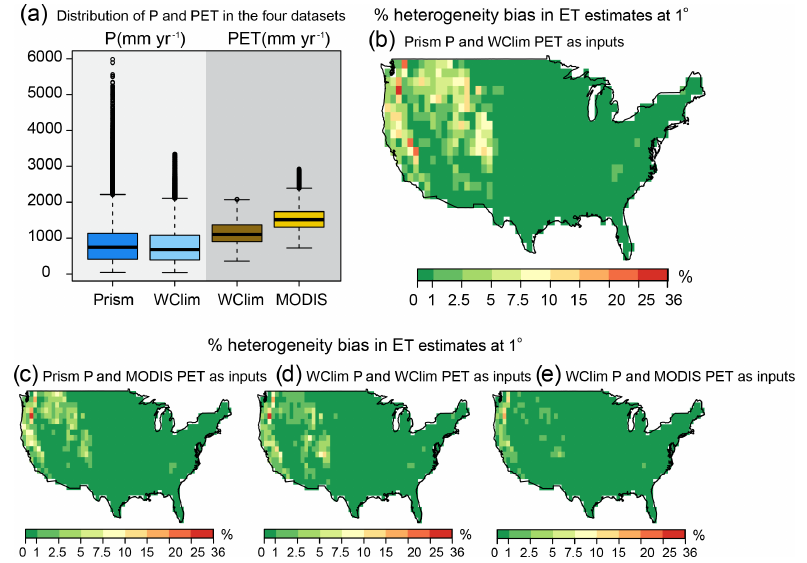
Figure 4. The distribution of P and PET in the four datasets is shown in panel (a) . Estimated heterogeneity bias (Eq. 4) across the contiguous US using 4km values of (b) Prism P and WorldClim PET, (c) Prism P and MODIS PET, (d) WorldClim P and WorldClim PET, and (e) WorldClim P and MODIS PET as inputs. WClim: